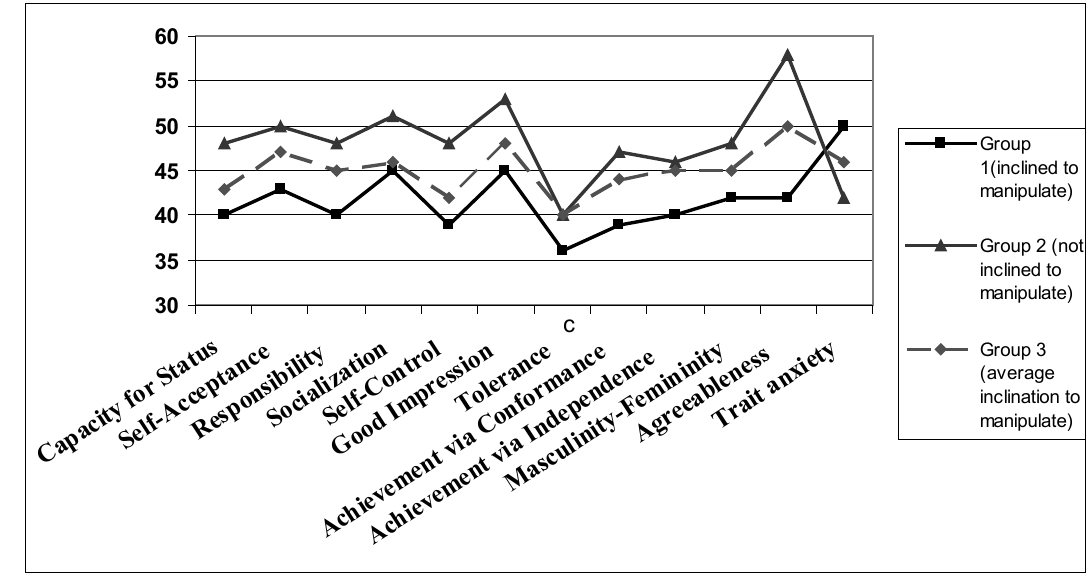
Fig. 1 Comparative diagram of the research (cid:222) ndings according to CPI-462, 5FPQ, personal anxiety